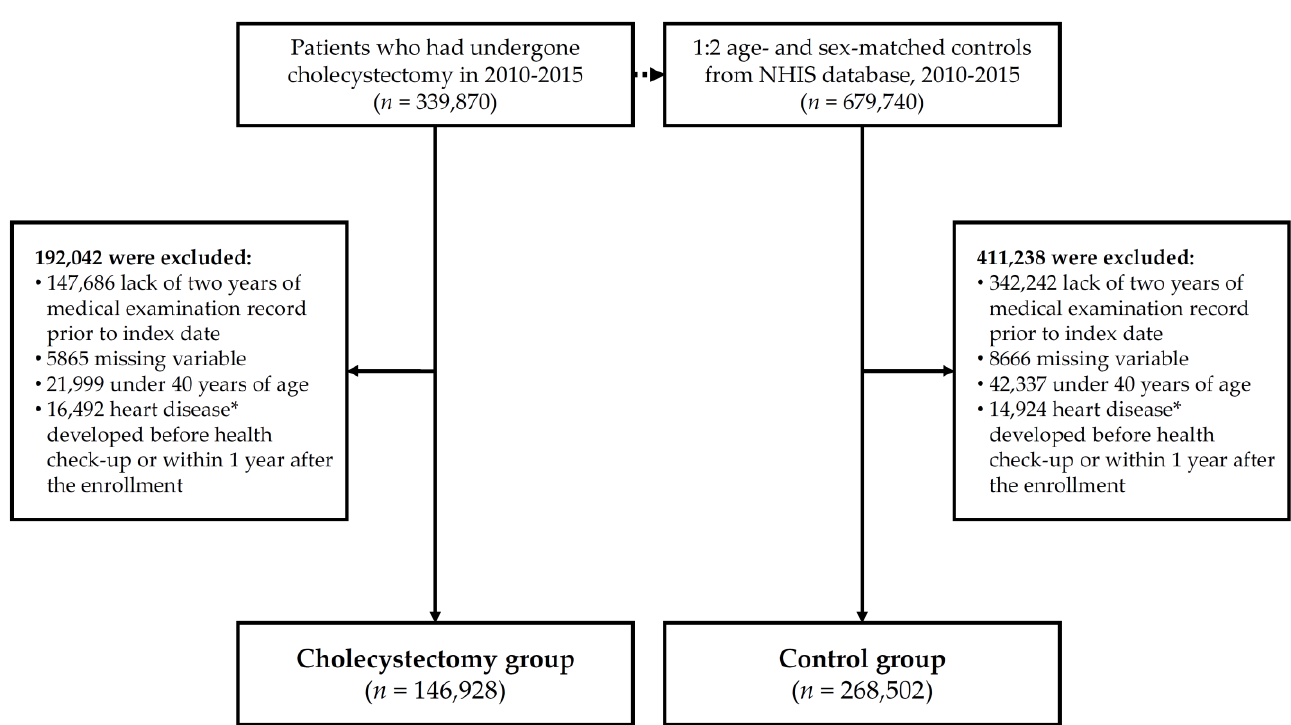
Figure 1. Flow chart of study population. NHIS, National Health Insurance System. * Heart disease includes myocardial infarction, congestive heart failure, and atrial fibrillation.